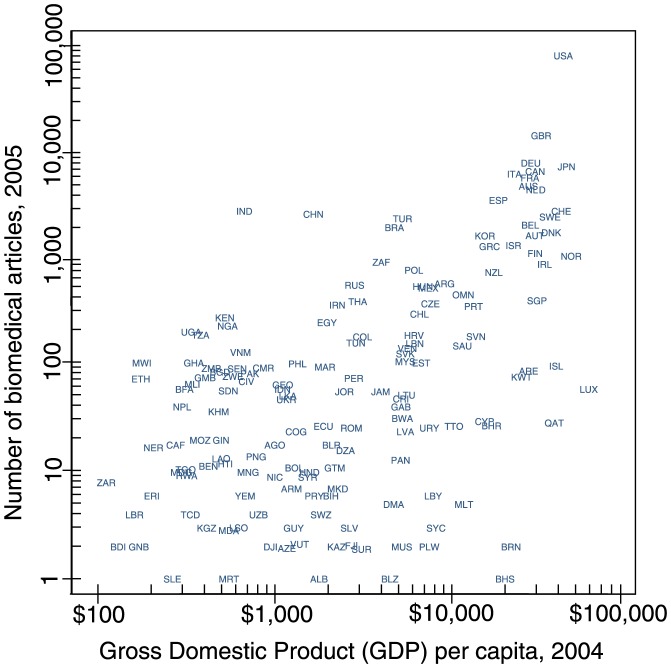
Relationship between the national GDP per capita in 2004 and the quantity of research published by researchers in 2005, by country, plotted on a logarithmic scale (to spread out countries for visual inspection).Each three character string corresponds to the unique ISO 3166-1 alpha-3 code associated with each country (see Table S4 in File S1 for complete list).